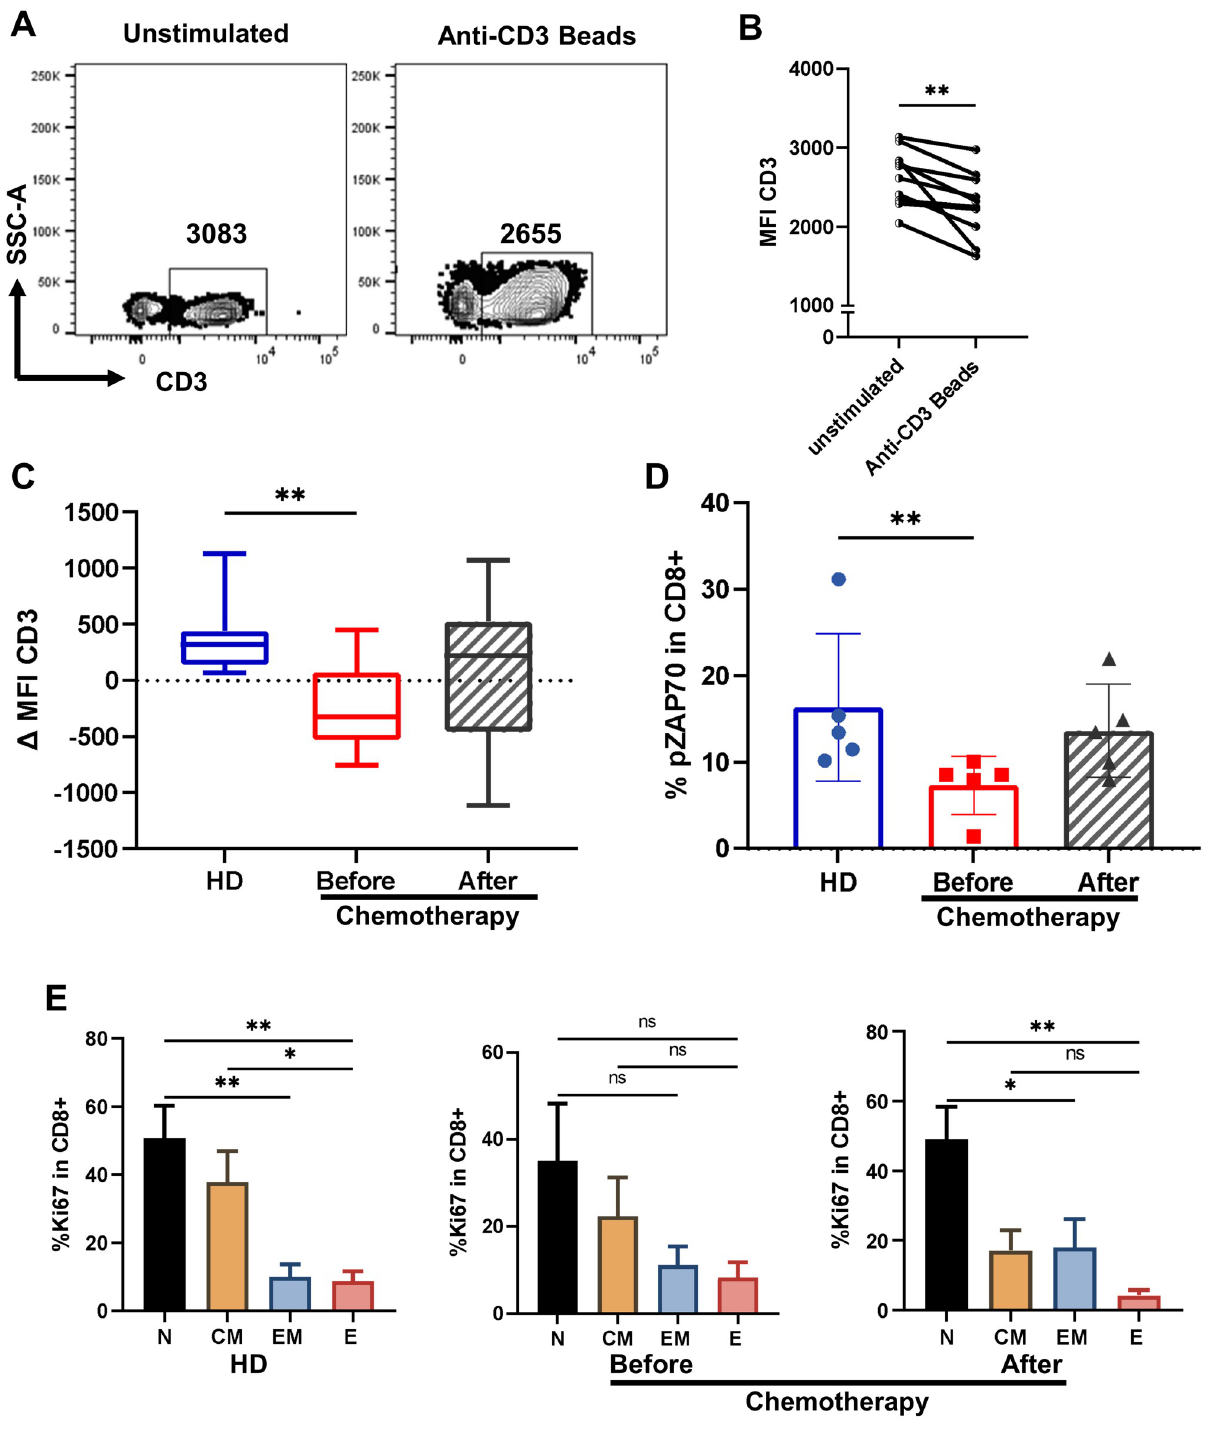
Fig 1. Chemotherapy restores deficient response of T cells in breast cancer patients. A . Contour plots from a representative donor’s PBMCs showing SSC-A vs CD3 in lymphocytes (by SSC-A vs FSC-A) after 72 h of unstimulated (left) vs after polyclonal stimulation with anti-CD3/CD28/CD2 micro beads (right), numbers in gates represents the mean fluorescence intensity (MFI) of CD3 measured by flow cytometry. B . Paired analysis of CD3 MFI quantification in 10 HD PBMCs unstimulated and after in-vitro stimulation for 72 hours with anti-CD3/CD28/CD2 micro beads. C . Quantification of percentage of CD3 internalization in HD (blue box), BC patients before (red box) and after chemotherapy (gray box with stripe). The dispersion of the data in boxes and whiskers (5–95%) is shown. D . pZAP70 expression in CD8+ T cells after stimulation (n = 5/group). E . Ki67